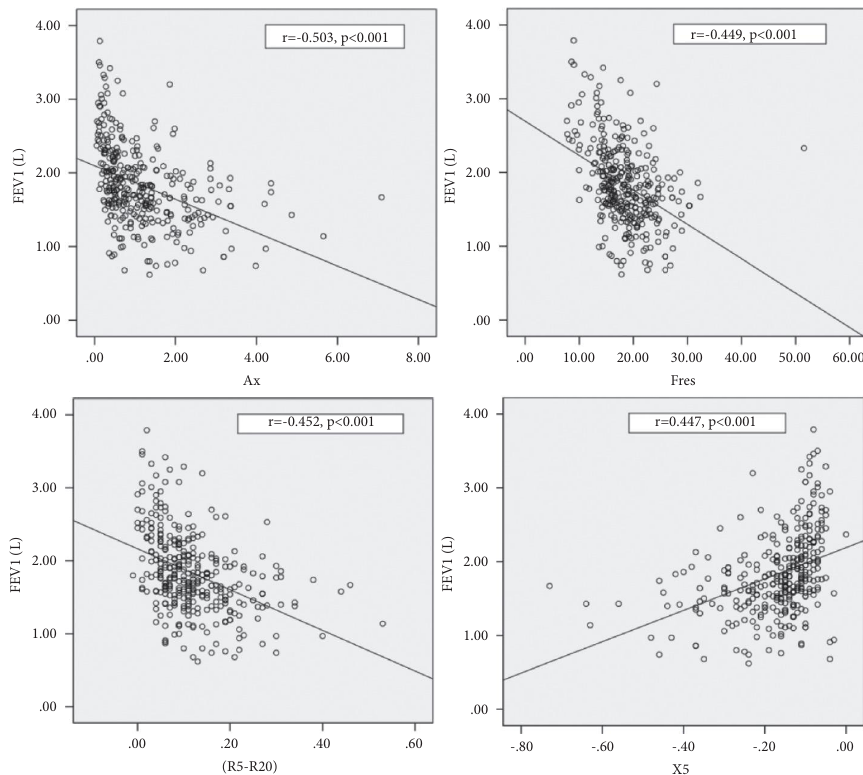
Figure 2: Relationship between FEV1 and IOS parameters. Statistical analyses are performed with Spearman correlation to compare correlation between FEV1 and IOS parameters. Moderate negative correlations were observed in FEV1 and Ax ( r � − 0.503), Fres ( r �− 0.449), and R 5– R 20 ( r � − 0.452); p < 0 . 001. By contrast, moderate positively related to FEV1 and X5 ( r � 0.477); p < 0 .